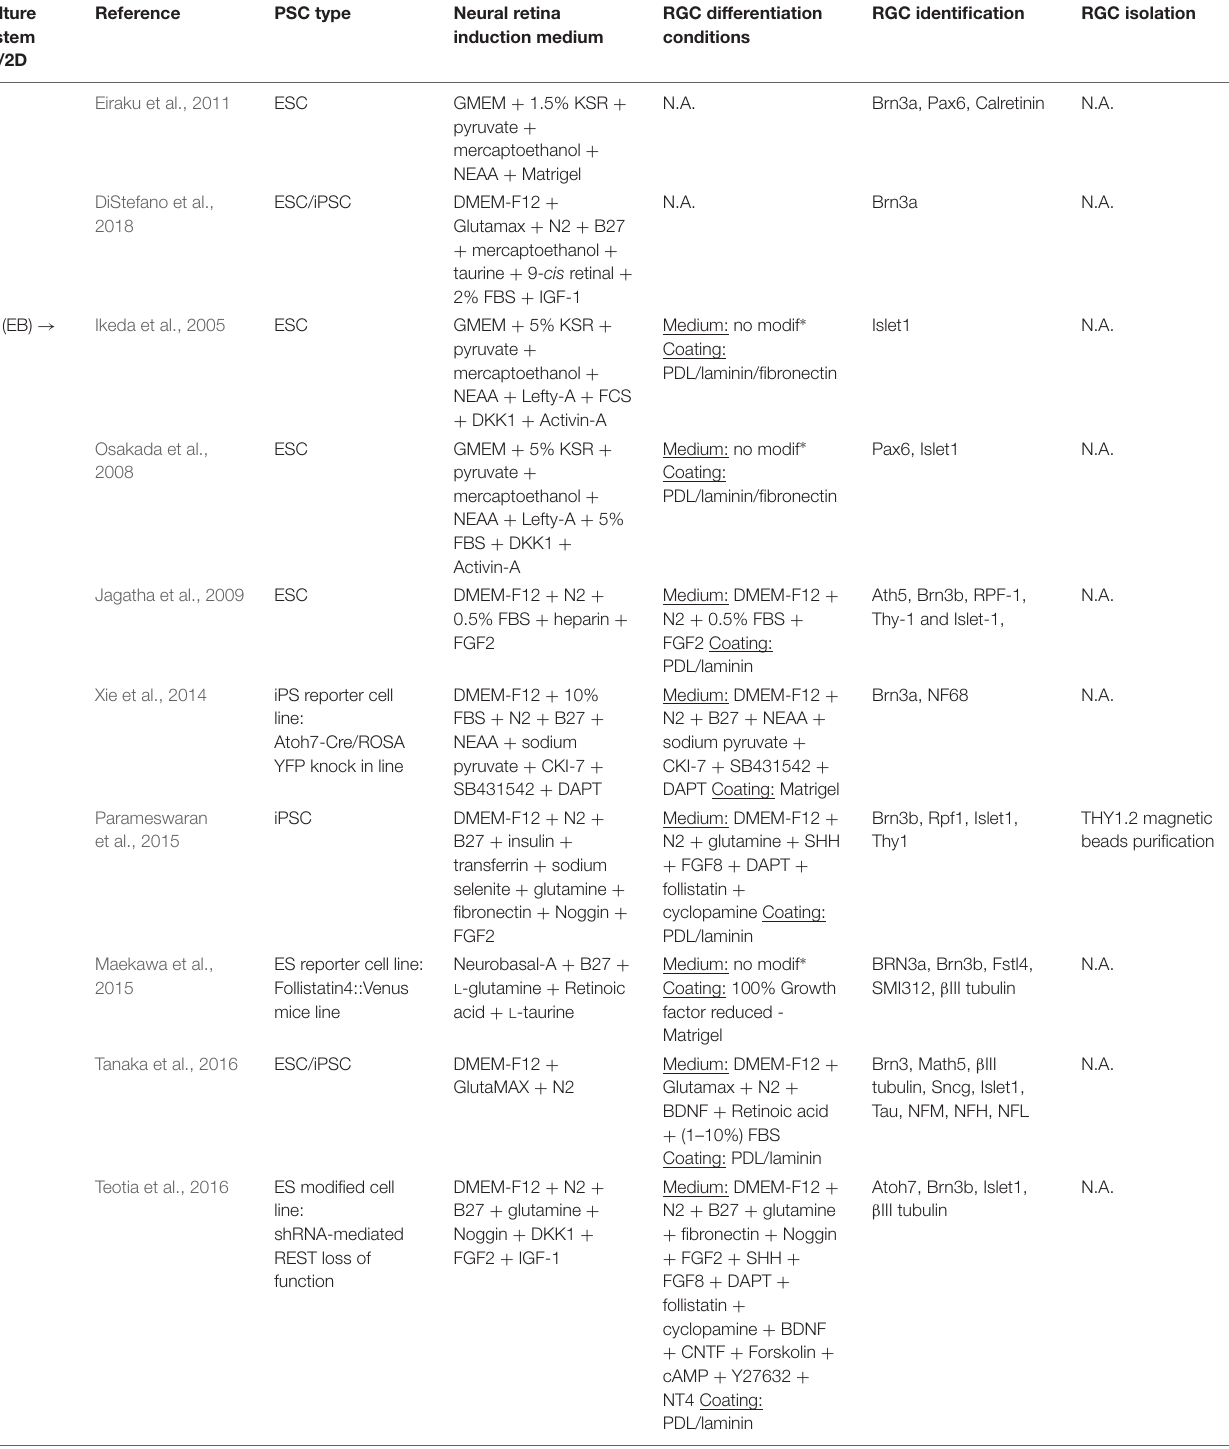
TABLE 1 | Retinal ganglion cell (RGC) differentiation protocols from mouse pluripotent stem cells. Culture system